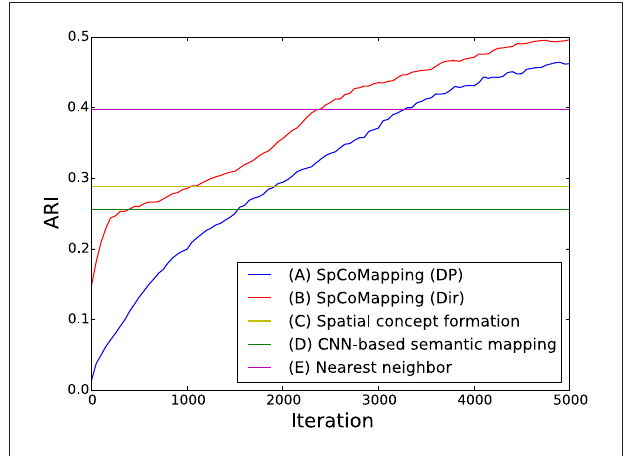
FIGURE 5 | Example of the changes in the ARI by iteration (Room2ldk4).